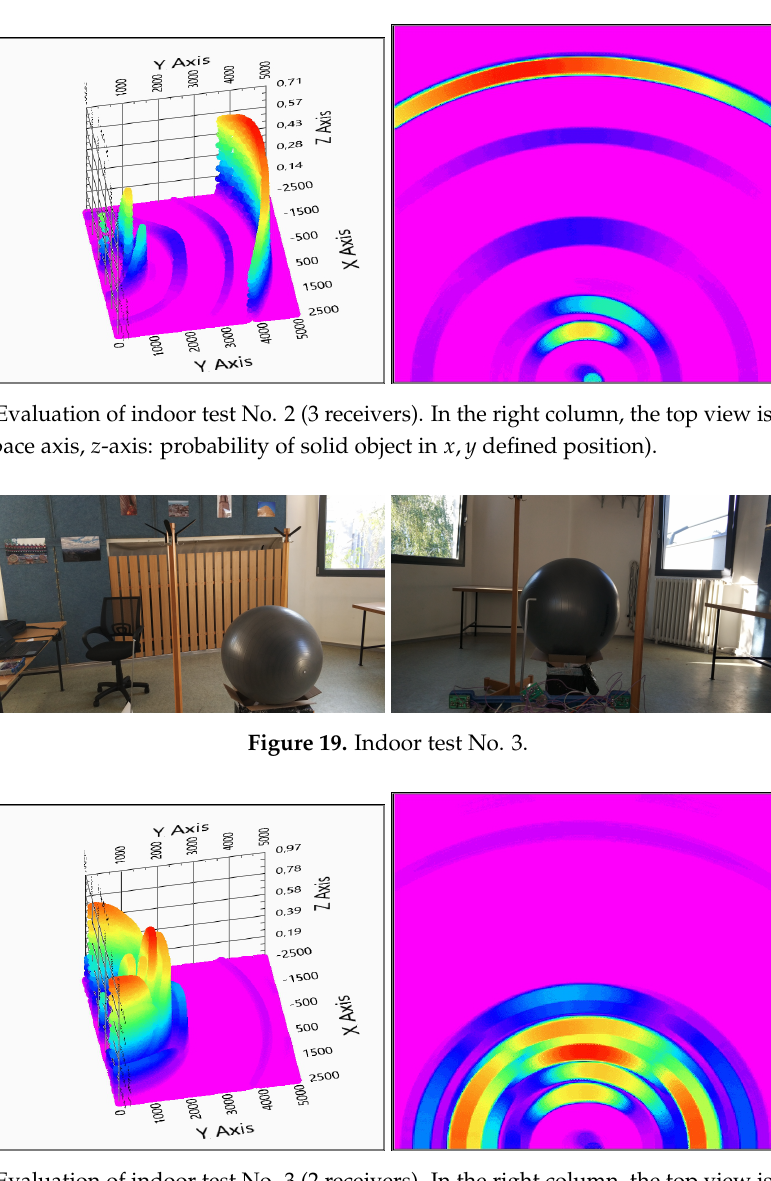
Figure 20. Evaluation of indoor test No. 3 (2 receivers). In the right column, the top view is also shown ( x , y : x , y space axis, z -axis: probability of solid object in x , y defined